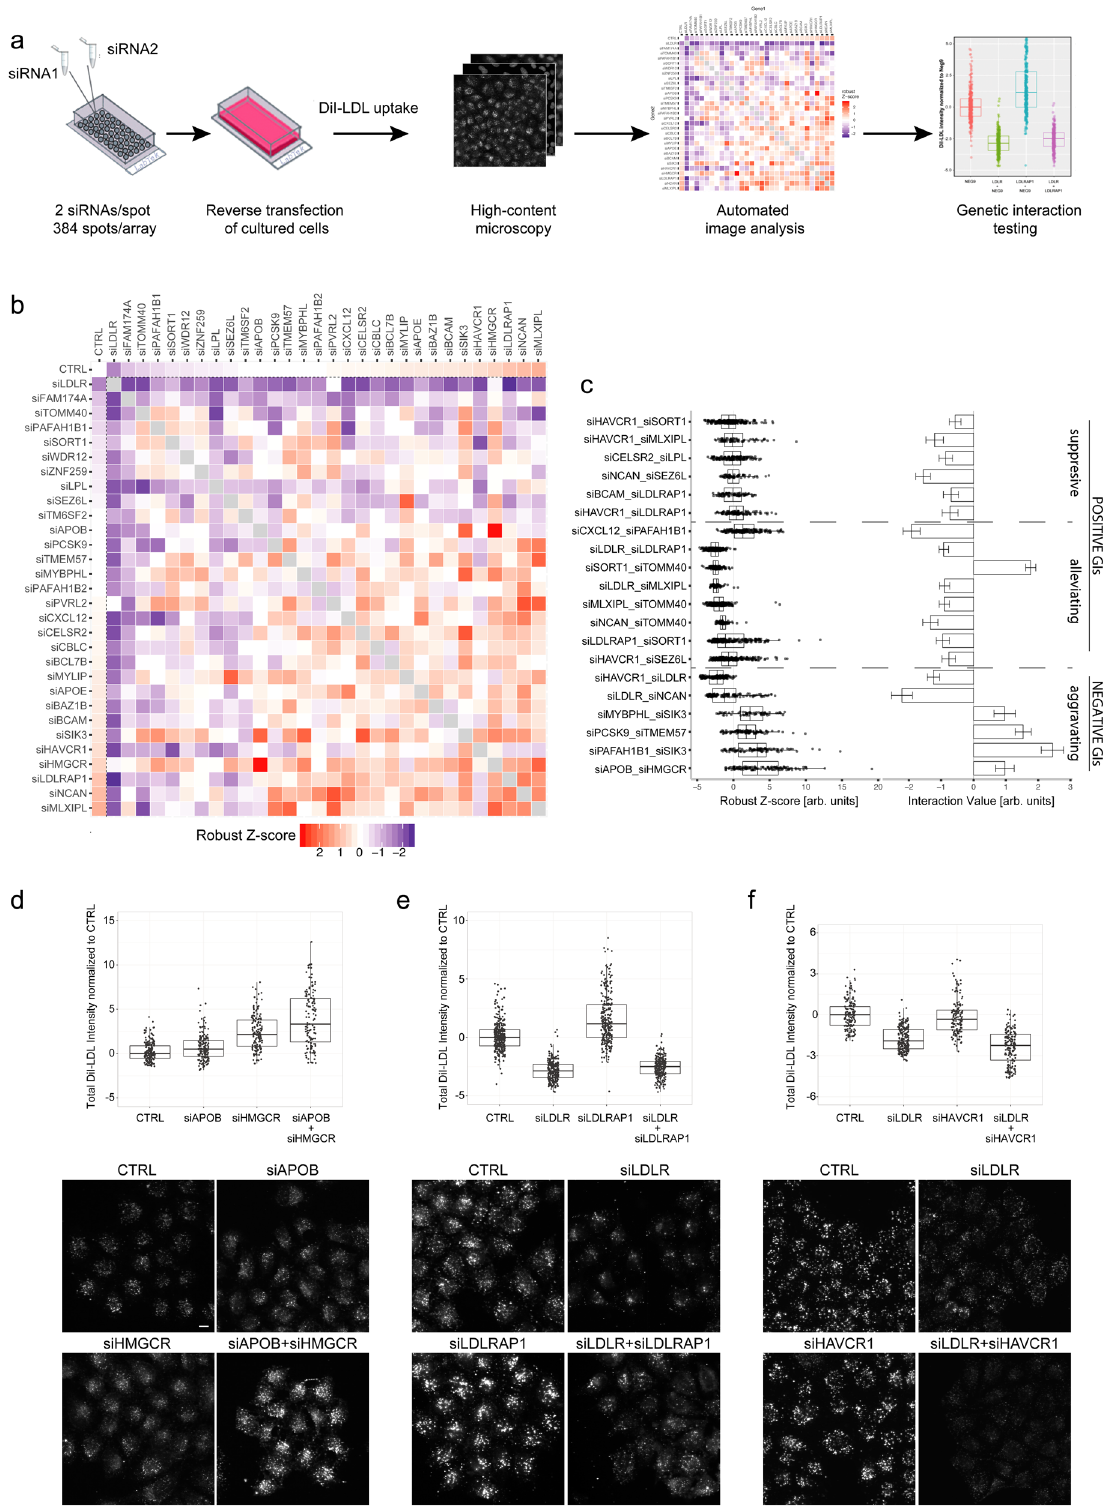
interactions and additive effects, we conducted, analogously to the genetic analyses, robust linear regression model fi tting. Initially, we used Schwarz ’ s BIC model estimation to determine potential GIs and AEs. Then we calculated p -values from t -values of the linear regression model term for single and double knockdowns (see ‘ Methods ’ ). We corrected these p -values for multiple com- parison testing with FDR. This identi fi ed 37 gene pairs, for which